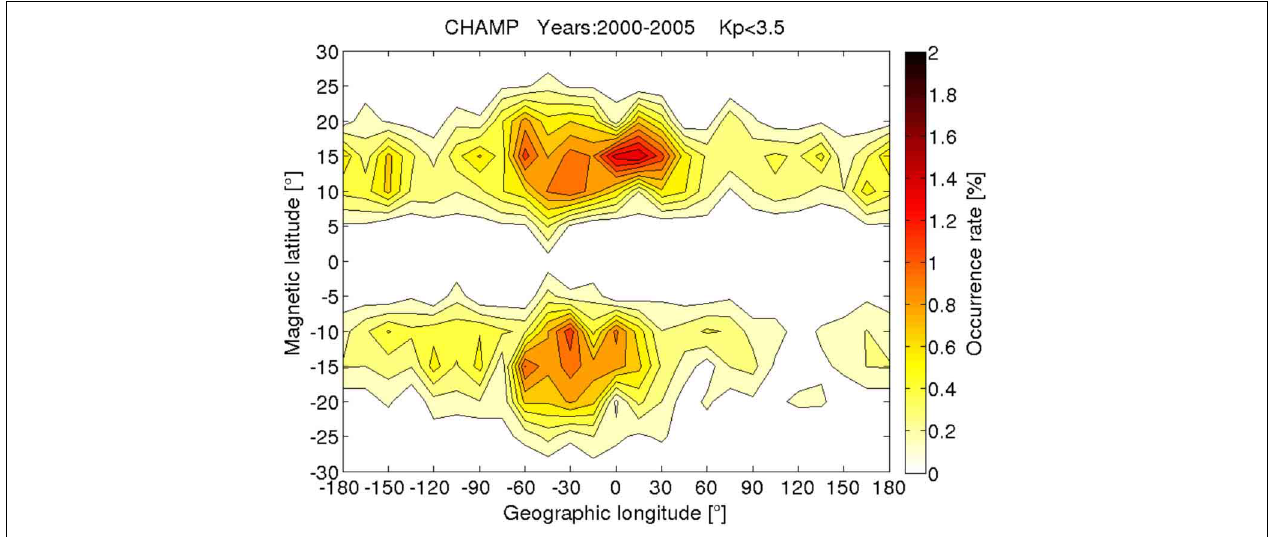
FIGURE 4 | Global distribution of intermediate-scale plasma structures. The peak in occurrence rate coincides with the crest of the equatorial ionization anomaly.